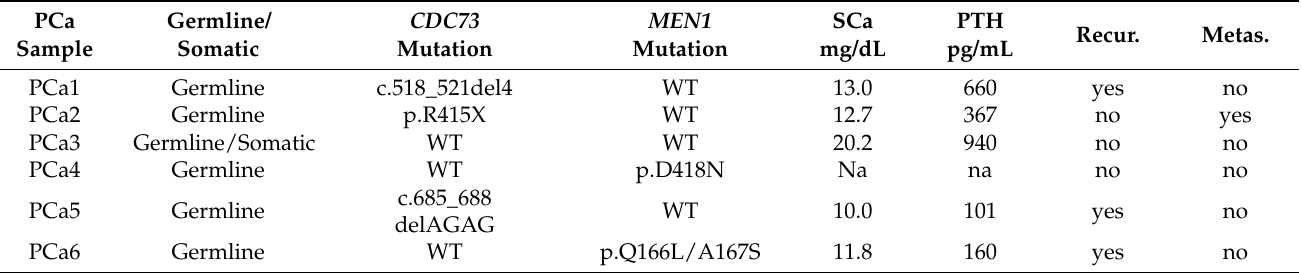
Table 1. Genetic, biochemical, and clinical features of the series of parathyroid carcinomas (PCas) analyzed by immunohis- tochemistry for YAP1 expression. Cell division cycle 73 (CDC73) , cell division cycle 73; MEN1 , multiple endocrine neoplasia type 1; SCa, serum total calcium; PTH, plasma parathormone: Recur., tumor local recurrence; Metas., distant metastasis; WT, wildtype gene sequence. All samples were included in previous studies